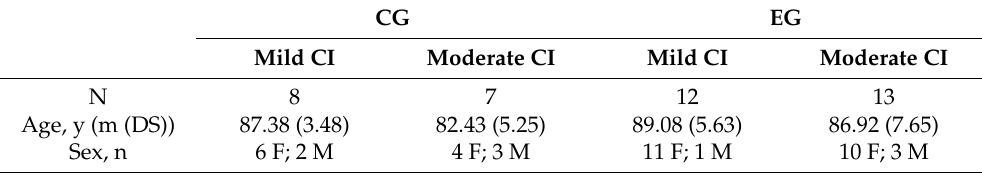
Table 3. Comparison of initial and fi nal CG and EG.